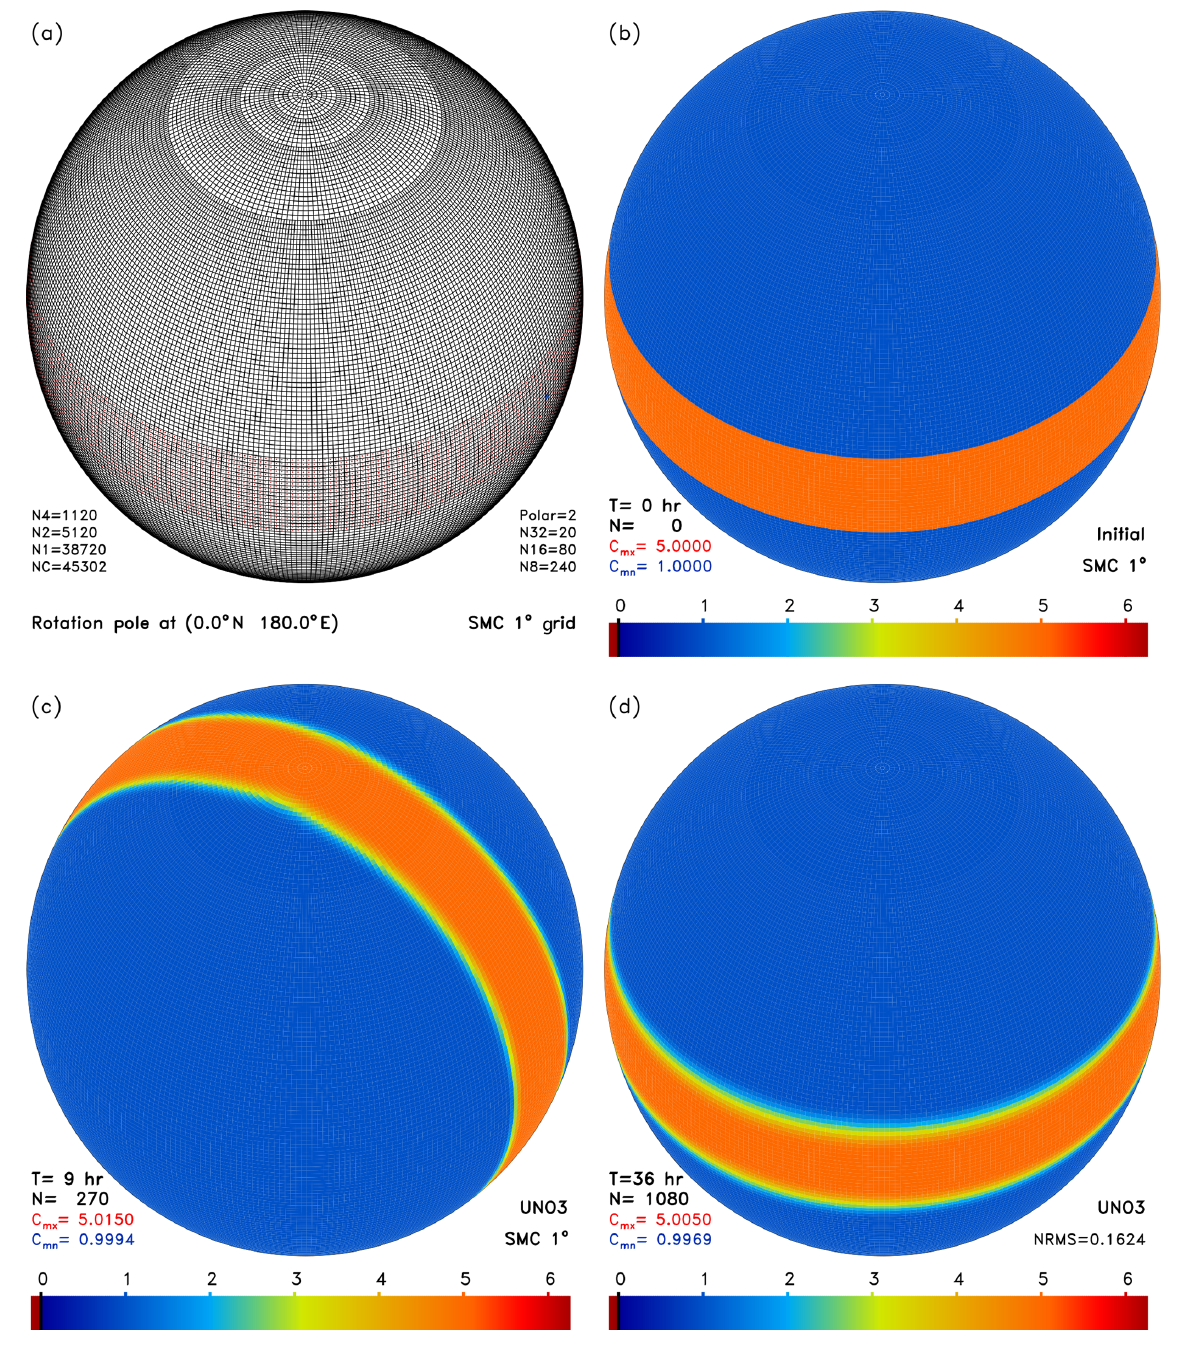
Figure 2. The global transportation test on the SMC1 ◦